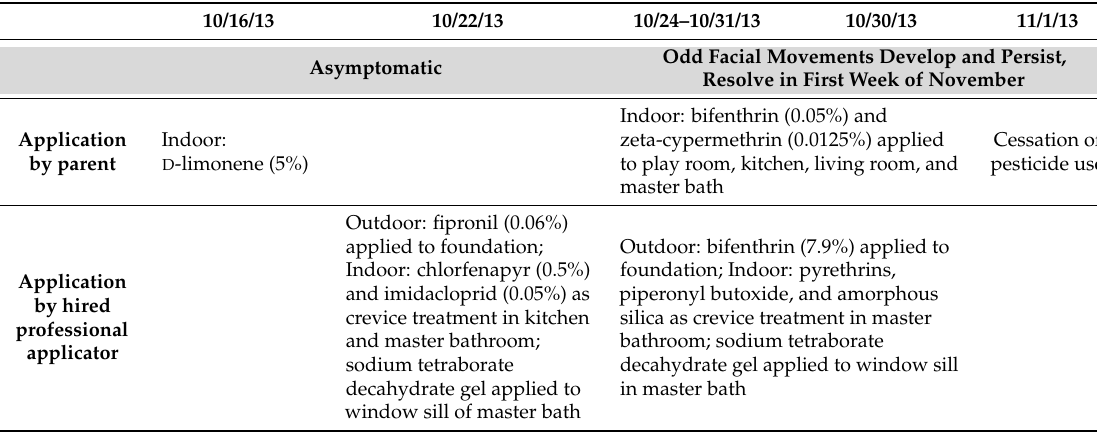
Table 1. Pesticide active ingredient applications and symptom